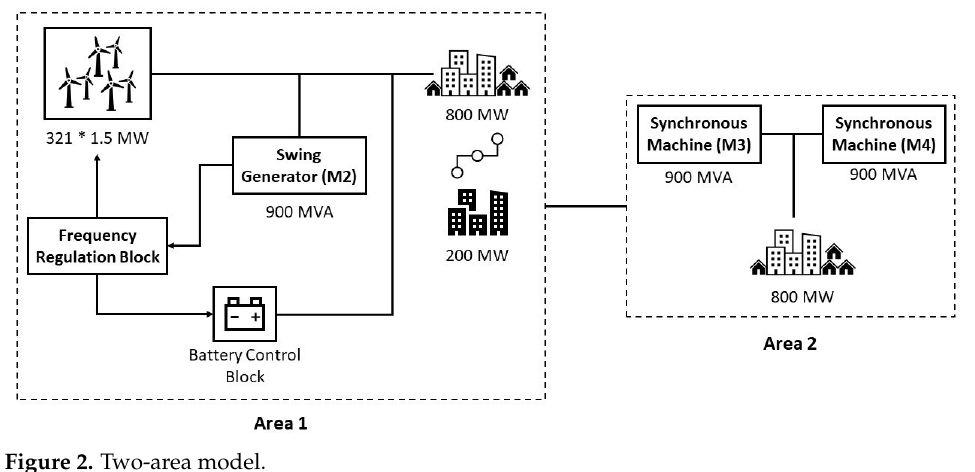
Figure 2. Two-area model. Table 2. Parameters of the two-area